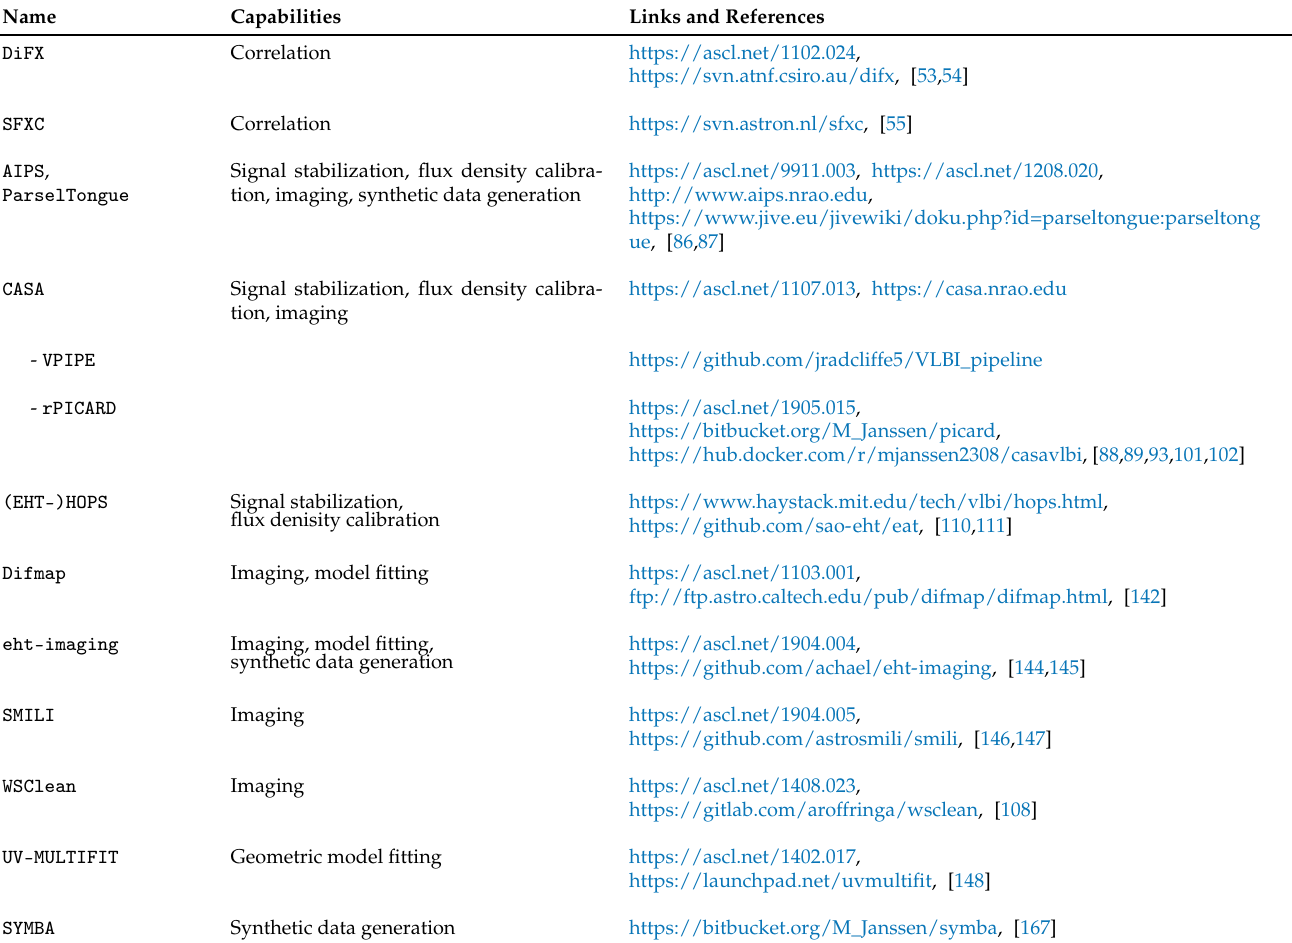
Table 2. Major VLBI software packages and their capabilities. AIPS and Difmap are still supported by their originators; requested features and bug fixes can be implemented. All other packages are actively being developed and supported by larger communities and